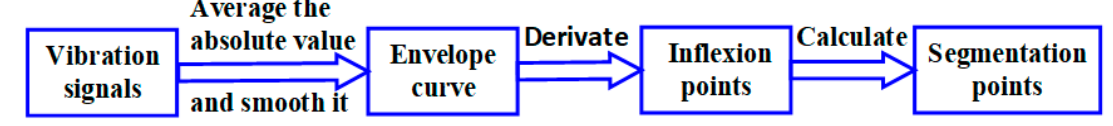
Figure 6. Process of computer segmentation of the signal.